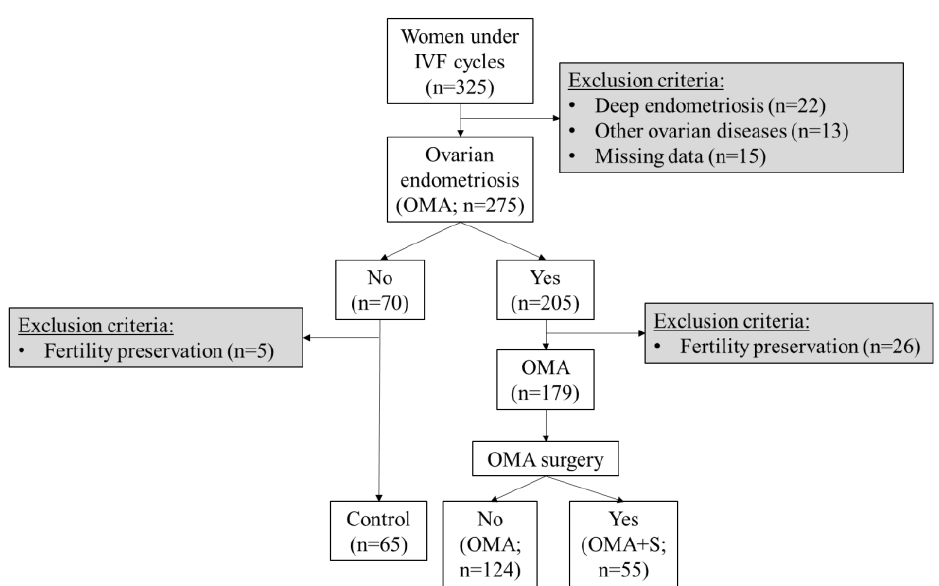
Figure 1. Study design and flow chart. Sample size (n) is indicated in each category. The control group comprised 36 women with tubal factor, 15 women with low ovarian reserve, and 14 women with polycystic ovary syndrome.